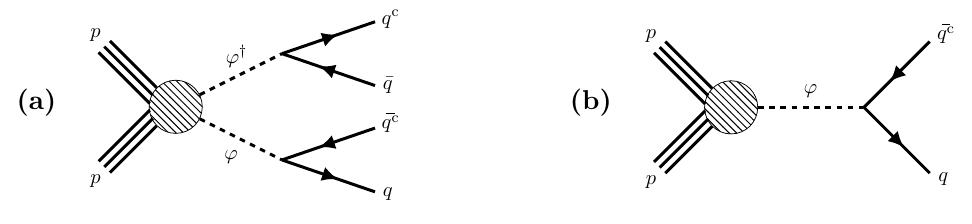
Figure 2 . (a) Pair and (b) single production of a color-sextet scalar at LHC. The scalar decays to an up-type quark pair q I q I (assuming Y = 4 / 3 for the sextet and flavor-diagonal λ IJ in (2.4)) if m ϕ > 2 m q . I